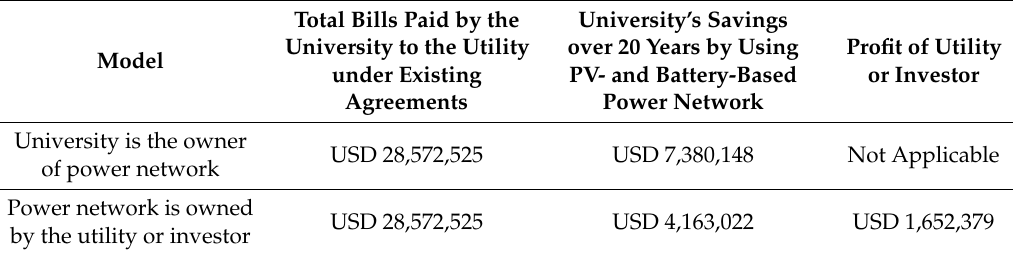
Table 5. Summary of financial